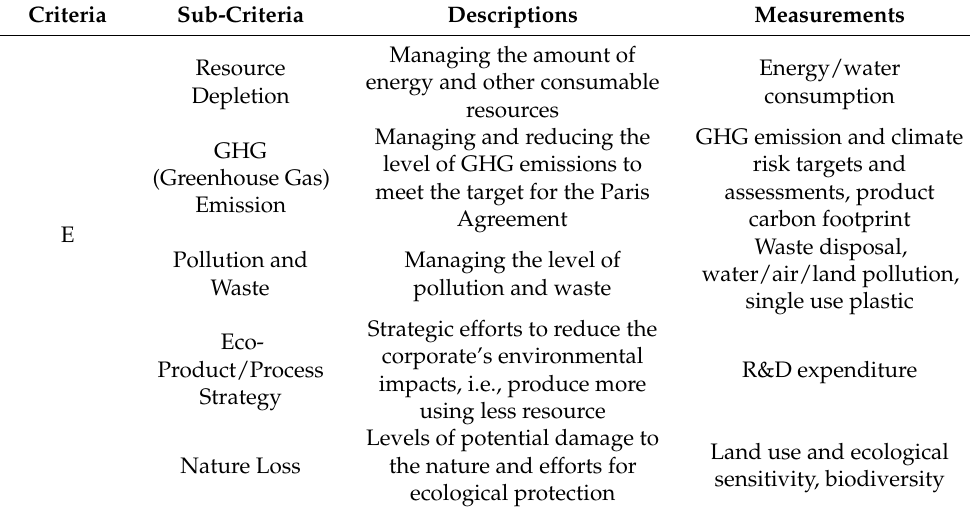
Table A5. Sub-criteria (environmental factors): definitions and descriptions of key components.